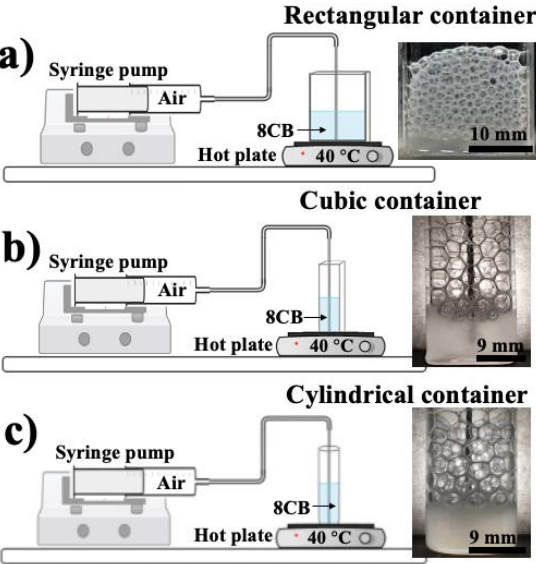
Figure 1. Experimental setup used to fabricate LC foams under different geometric confinements: ( a ) rectangular, ( b ) cubic, and ( c ) cylindrical. The containers are placed on a hot plate heated to 40 ° C to facilitate the creation of the bubble in the 8CB LC. The air is injected into the LC, using a syringe pump that is connected to a needle via polyethylene tubing and placed in the center of the containers. The syringe pump helps vary the airflow rate between 2 mL/min and 62 mL/min.